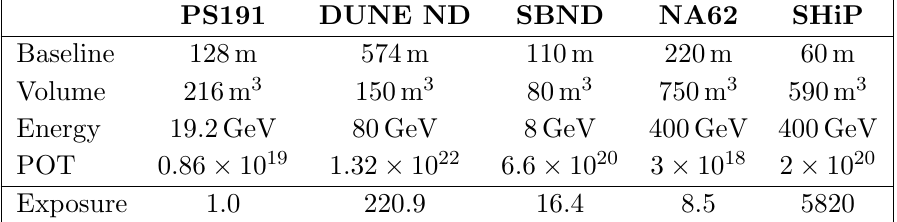
Table 3 . Comparison between experiments mentioned in this work. The exposure is de(cid:12)ned as POT (cid:2) Energy (cid:2) Volume (cid:2) Baseline (cid:0) 2 with respect to PS191, where \Energy" is the proton beam energy. The NA62 and SHiP experiments are not directly comparable with SBND and DUNE ND, in that di(cid:11)erent technologies are involved; the RICH detectors are adopted as (cid:12)ducial volume for NA62, whereas for SHiP, we estimate the volume as the cone contained in the \hidden sector" vacuum vessel. The volume is a driving feature in the de(cid:12)nition of the total exposure and it is of utter importance for searches of decay-in-(cid:13)ight